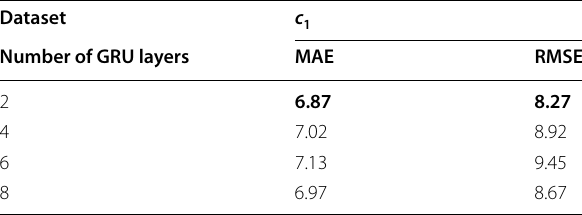
The bold value means the best results